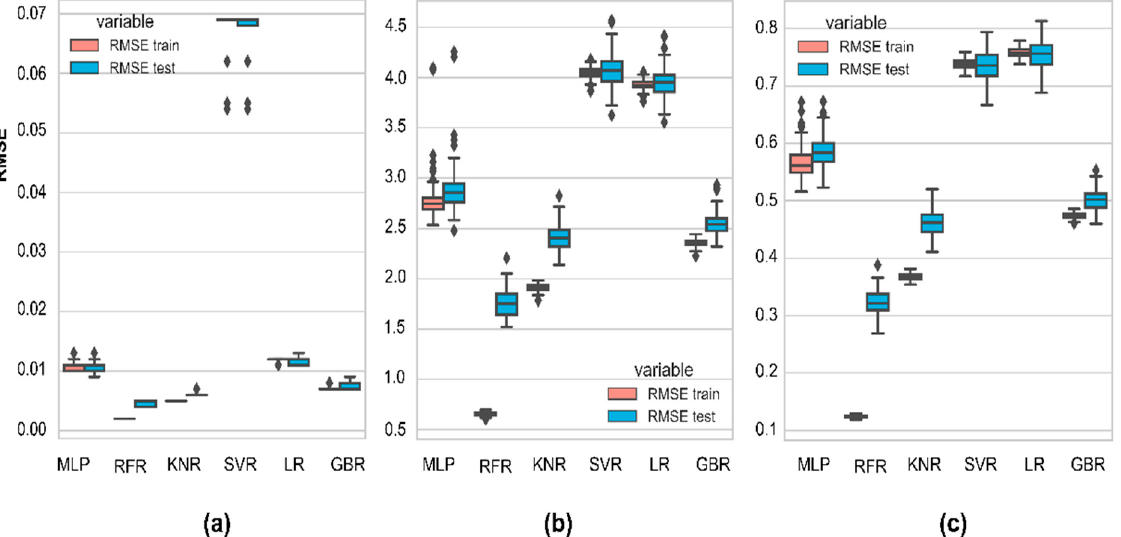
Figure 6. Boxplots of model performance (RMSE) on 100 datasets: ( a ) As prediction; ( b ) Fe prediction; ( c ) Mn prediction. Table 2. Model performance on 100 testing data sets for different targets (mean R 2 score ± standard deviation).